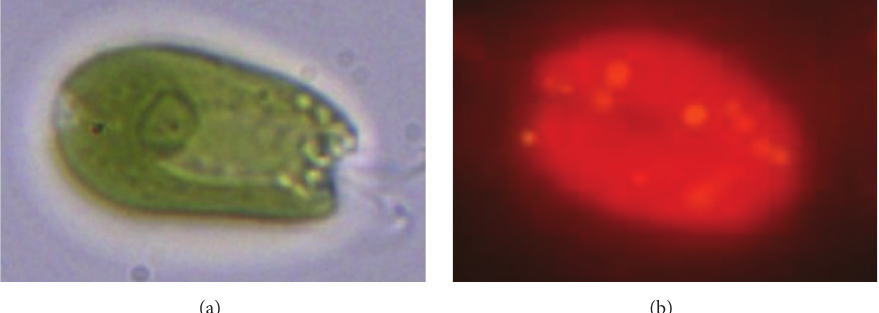
Figure 1: Microscopic images of a Tetraselmis suecica cell. (a) Cell before being stained by the Nile red dye. (b) Cell after being stained by the Nile red dye.